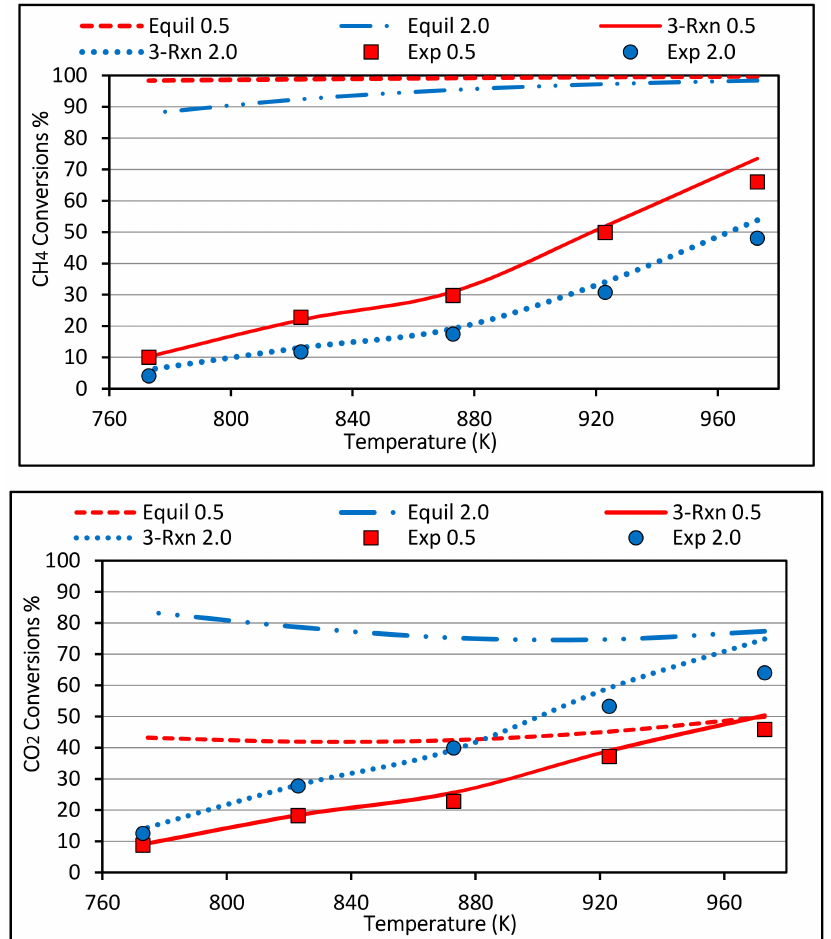
Figure 9. Impact of temperature on CH 4 (upper plot) and CO 2 (lower plot) conversions at GSV = 5.56 × 10 − 4 m 3 / s-kg; feed CH 4 / CO 2 = 0.5, 2.0. “Exp” = experiment; “Equil” =